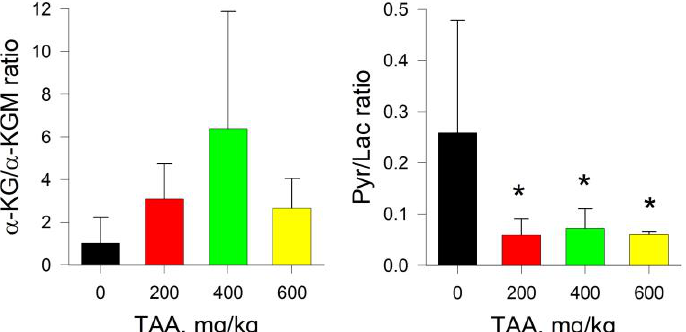
Figure 6. α - KG/α -KGM and Pyr/Lac ratios for kidney tissue of control and TAA-treated rats. p -values by Tukey’s test: *— p < 0.1; black stars mean a pairwise comparison to control (for details see Table and Figures in Supplement S1).